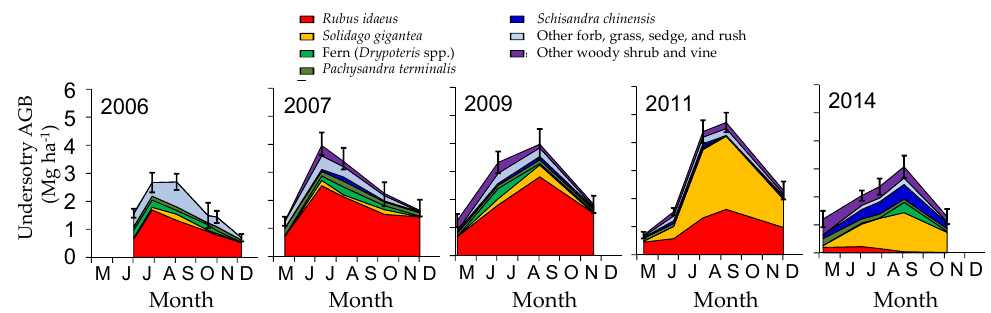
Figure 2. Seasonal changes in understory AGB in 2006, 2007, 2009, 2011, and 2014. Error bars represent 1 standard error of total AGB ( n = 10).